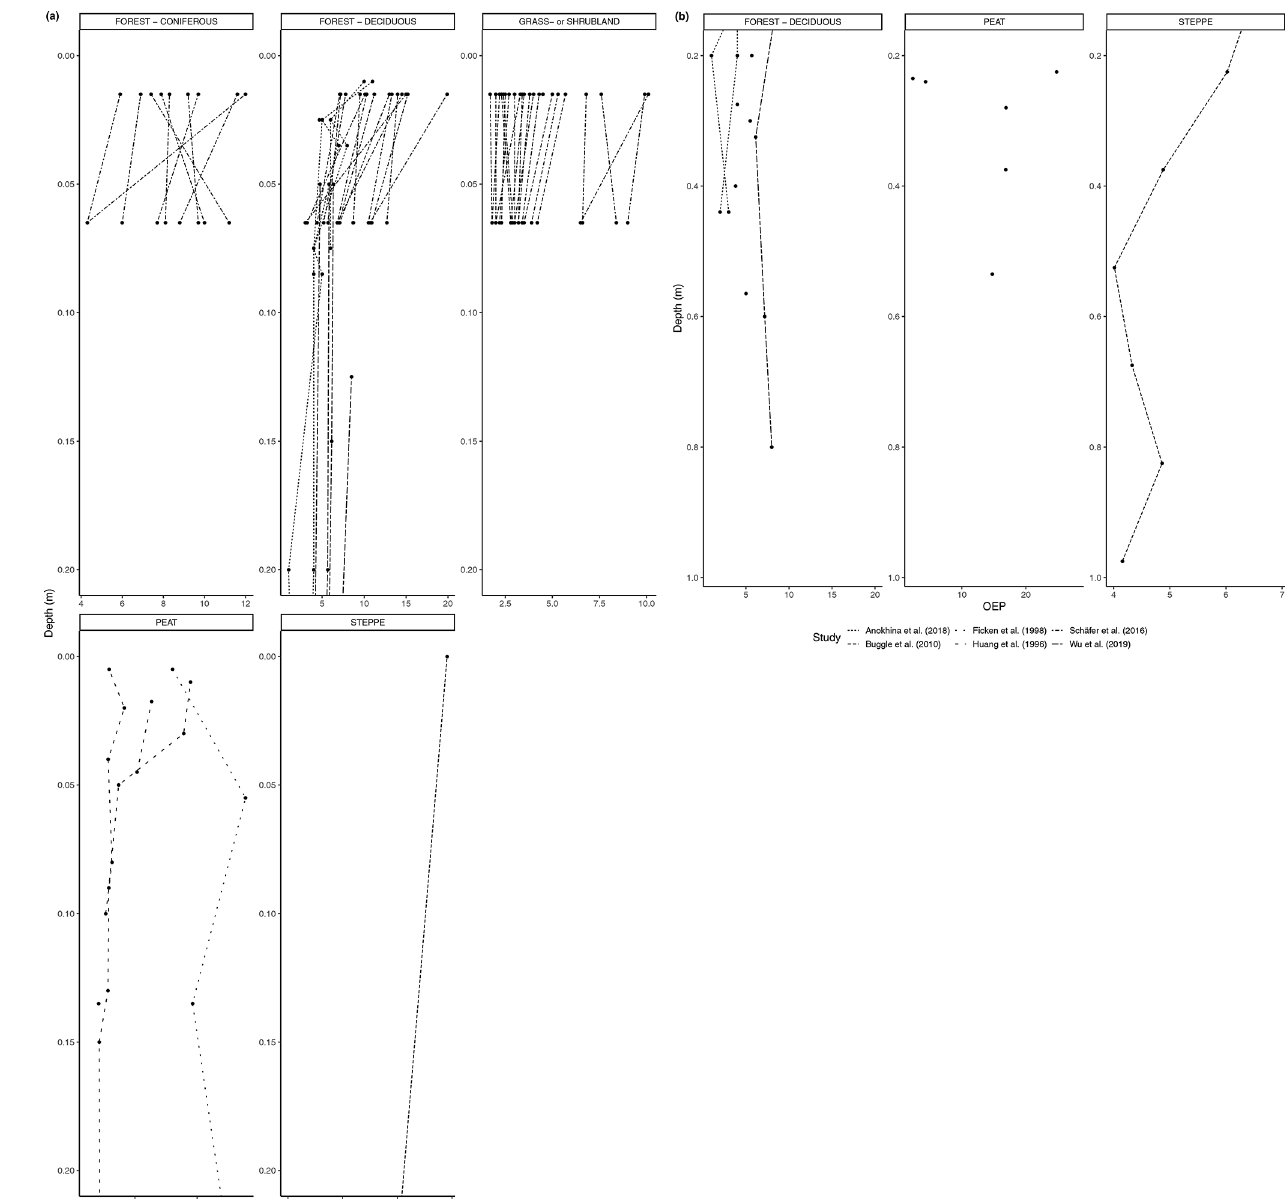
Figure 9. (a) OEP of n -alkanes in soil from 0 to 20cm. (b) OEP of n -alkanes in soil below